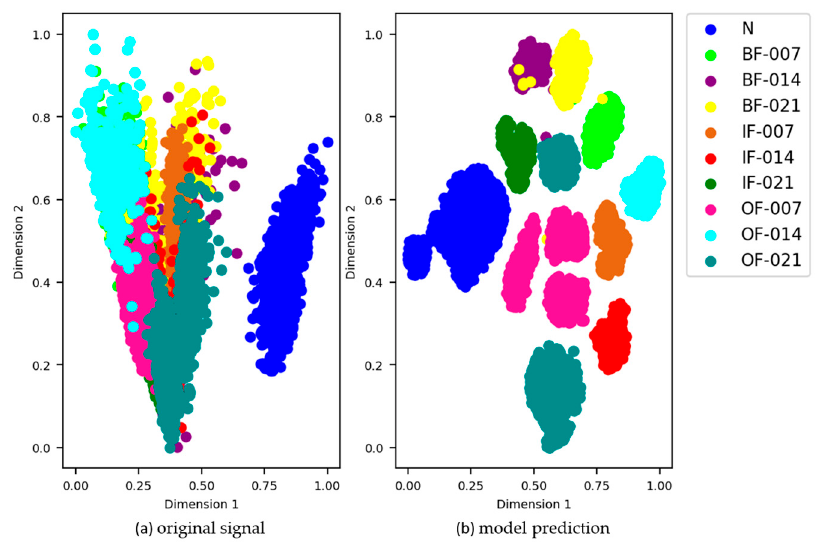
Figure 11. t-SNE representations of the CWRU testing samples: ( a ) original signal and ( b ) model prediction. ( b ) model prediction.